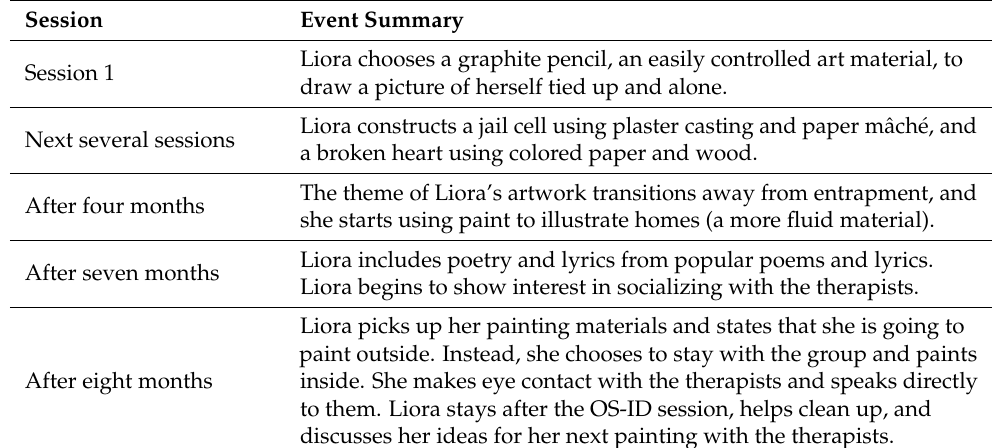
Table 4. Summary of Liora’s ten-month OS-ID